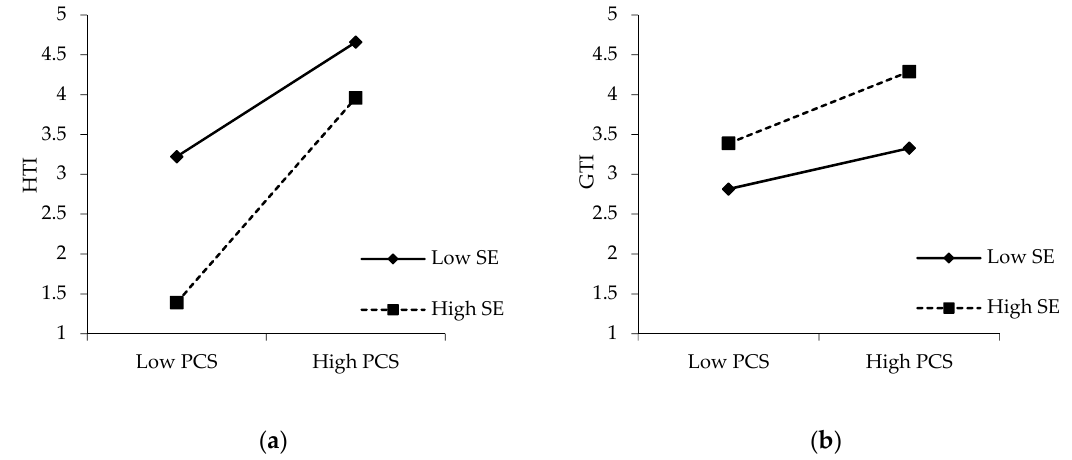
Figure 3. Moderating effects of perceived social exclusion between ( a ) community support and health topic interaction; ( b ) community support and general topic interaction.